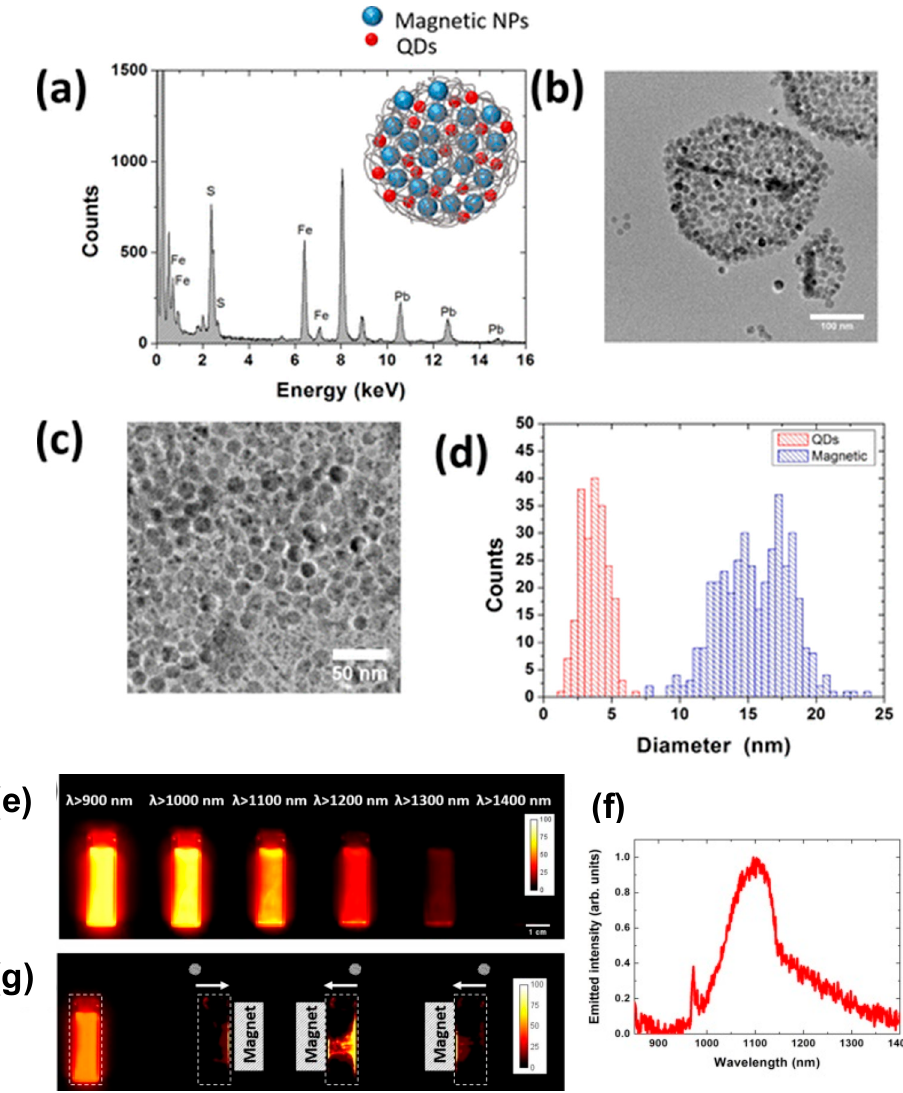
Figure 6. Top: Characterization of luminescent-magnetic HNS. ( a ) Compositional analysis (EDX) of a PLGA nanostructure denoting the presence of elements of both magnetic NPs and QDs. (inset) Schematic diagram of the magnetic NPs and QDs in the PLGA nanostructure; ( b ) TEM image of a typical PLGA nanostructure synthesized in this work; ( c ) A detailed TEM image of a PLGA nanostructure revealing the presence of two types of NPs inside the structure; ( d ) Size distribution of both types of particles obtained from TEM images. The size distribution corresponds to the sizes of the magnetic NPs and QDs (right). Fluorescence analysis; ( e ) Infrared fluorescence images of a PBS solution containing the HNS, as obtained under 808 nm laser excitation and by employing different long pass filters; ( f ) Emission spectrum of HNS; ( g ) IR fluorescence images of the same dispersion in the presence of a magnet, demonstrating the potential for the magnetic control of the nanostructures while enabling visual tracking through the IR luminescence. Adapted from [56].